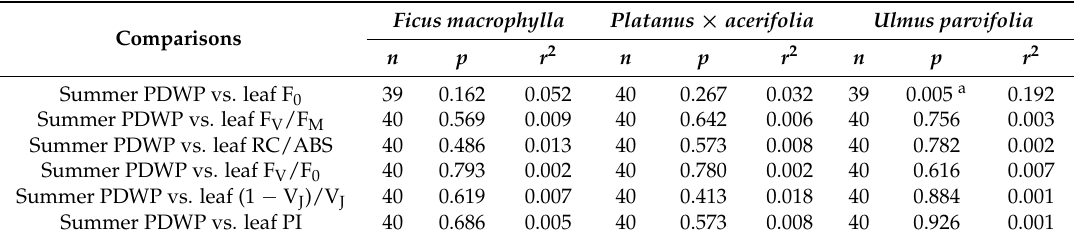
Table 1. Summarized results from simple linear regression analyses comparing summer leaf fluorescence with pre-dawn water potentials in Ficus macrophylla , Platanus × acerifolia , and Ulmus parvifolia . Ficus macrophylla Platanus × acerifolia Ulmus Comparisons